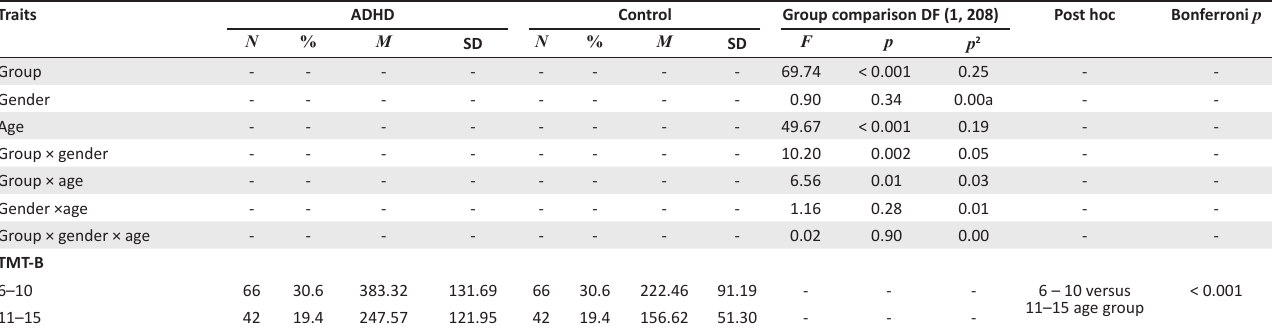
TABLE 2: Descriptive statistics and ANOVA results for trails–B. Traits